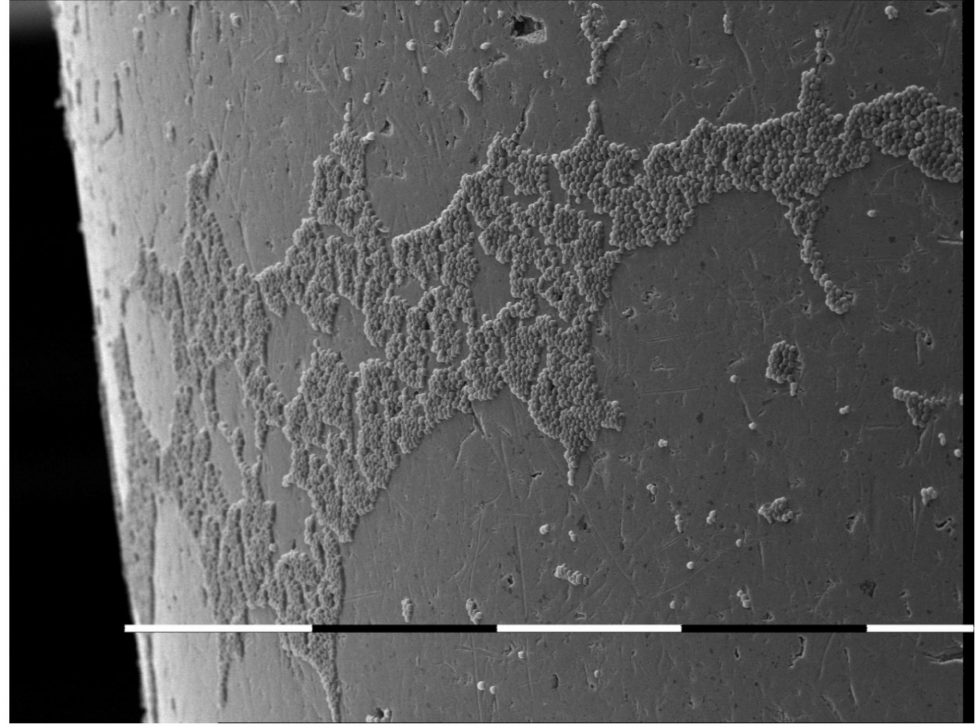
Figure 1. In vitro colonization of metal oral piercing with Candida albicans . SEM picture [6]. Oral piercing is a practice that is gaining popularity as a sign of individuality or membership in specific social groups [12]. Its prevalence is changing constantly due to trends’ fluctuations. In the Israeli youth population, for example, the prevalence of oral piercing is reported as being between 3.4% and 20.3% [13]. However, the Candida- related complications of tongue piercing are considered rare with only two reported clinical cases [9,10]. The first case reported the appearance of symptoms following a tongue piercing insertion in a young woman. The case is interpreted by the authors as an acute infection [9]. C. albicans , C. tropicalis , C. glabrata , and C. krusei were identified from the sample. The treatment included piercing removal and combined antifungal and antibiotic therapy. The second clinical case addresses a 20-year-old healthy, white woman in a stable exclusively lesbian relationship. She was consulted together with her female partner for recurring vaginal infections of fungal origin. The patient also reported problems in the oral cavity related to her tongue piercing. The oral examination revealed that the piercing site is red and covered with a whitish coating. The burning sensation and the mouth soreness were evident for 10 days. Mycological testing revealed the presence of C. dubliniensis in both the patient and her partner. The patient was treated topically by vaginal lavage with boric acid and with oral nystatin suspension for 2 weeks. Her symptoms improved significantly after 2 weeks, and her test was negative after 2 months [10]. The presented clinical cases should not be classified as simple tongue piercing carriers. The acute infection in the first case and the presence of related comorbidity in the second case are rather a background for the development of candida